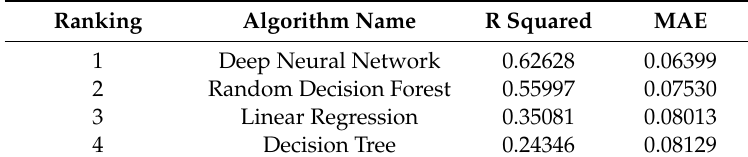
Table 4. The selected model per category.